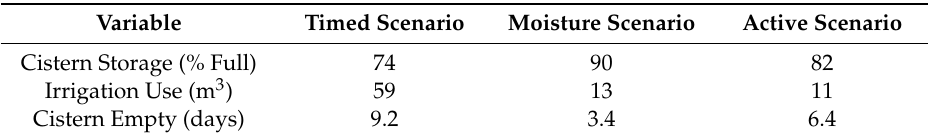
Table 6. Irrigation Performance Comparison (2004–2013)—Annual Averages. Variable Timed Scenario Moisture Scenario Active